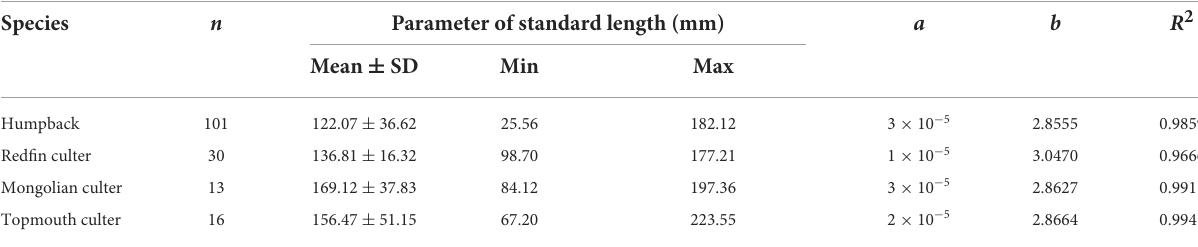
TABLE 1 Standard length–weight relationships for four fish species in Lihu Lake. Species n Parameter of standard length